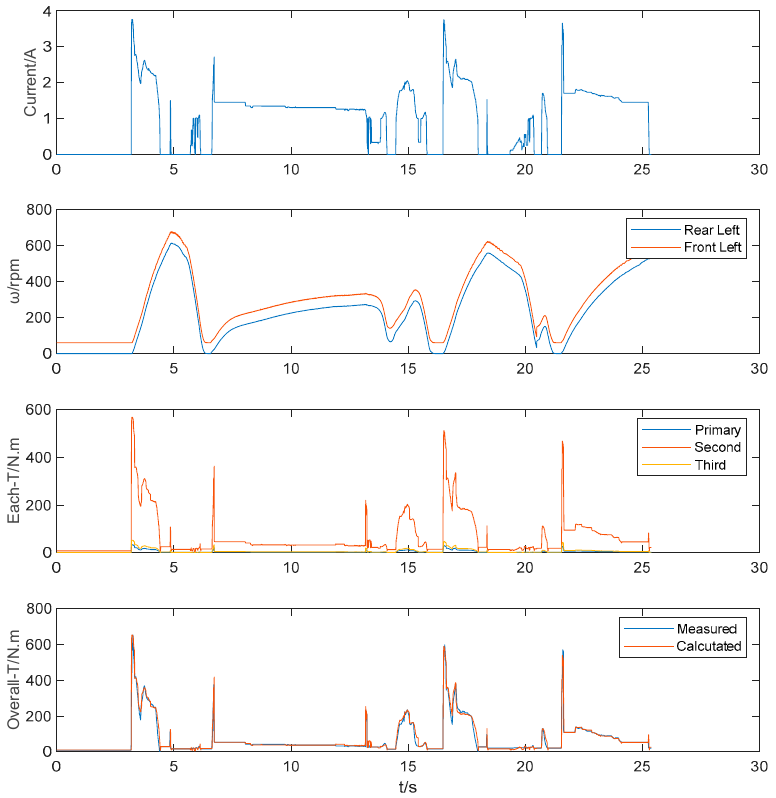
Figure 16. Real-car experiment in condition of slipping mode.